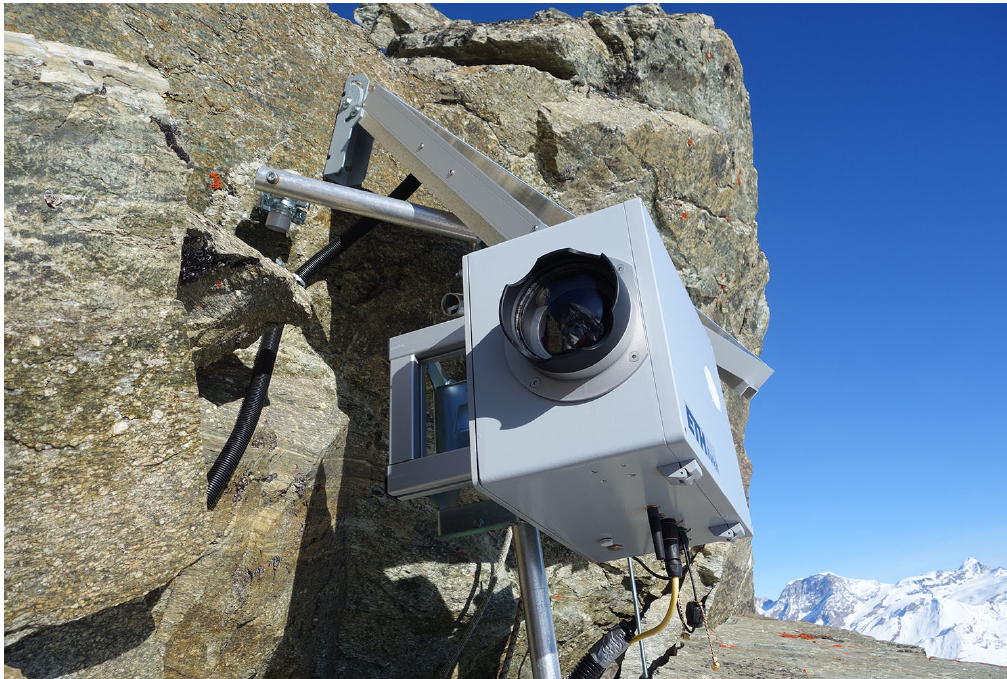
Figure C8. High-resolution time-lapse camera located at position MH19.